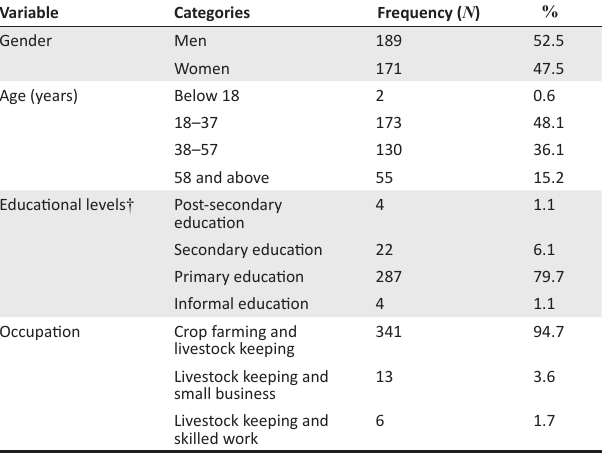
TABLE 1: Characteristics of poultry farmers ( N = 360). TABLE 2: Characteristics of information providers ( N = 22).